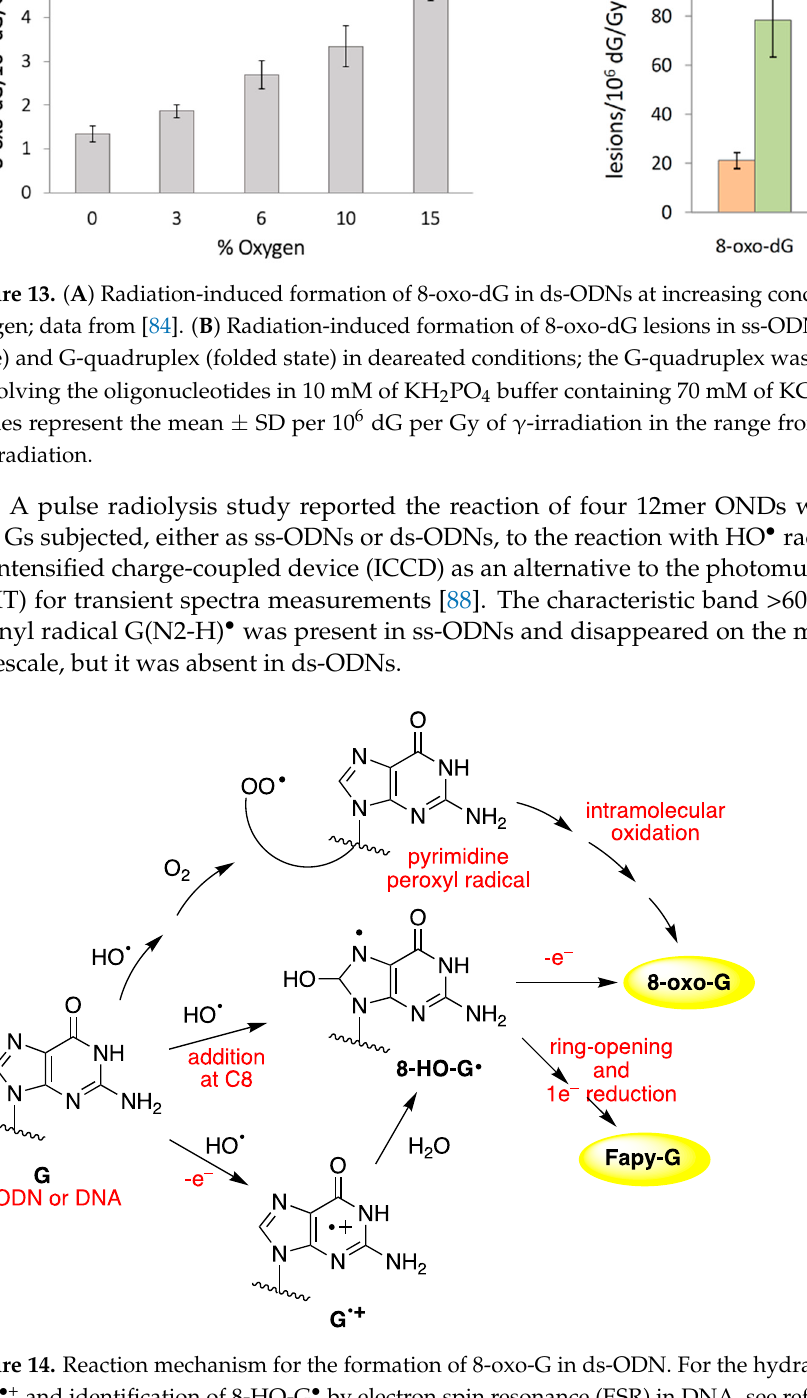
Figure 14. Reaction mechanism for the formation of 8-oxo-G in ds-ODN. For the hydration